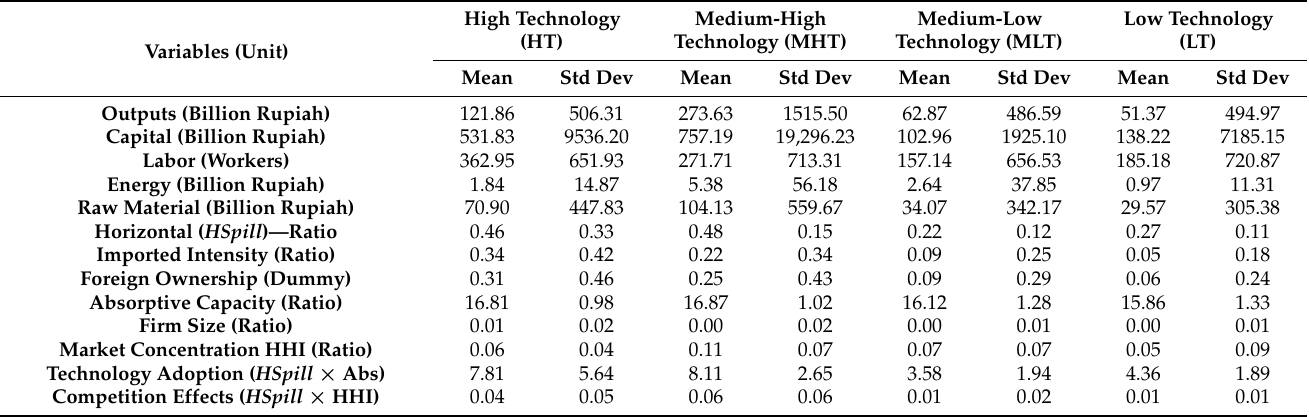
Table 3. Descriptive